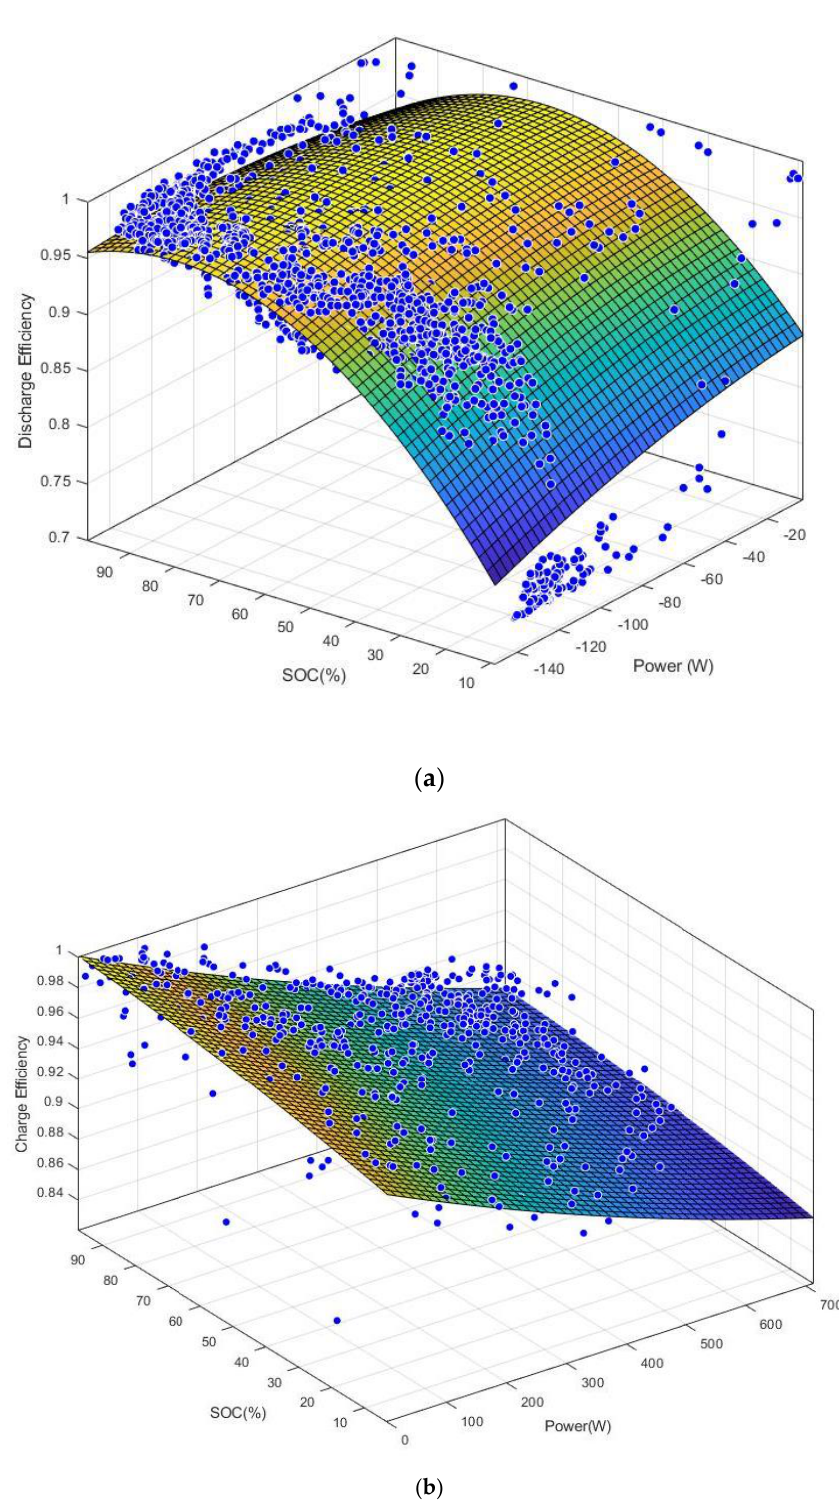
Figure 7. Efficiency variation with SoC and operating power of VRFB for ( a ) discharging and ( b ) charging for the three runs shown in Figure 4. ( b ) charging for the three runs shown in Figure